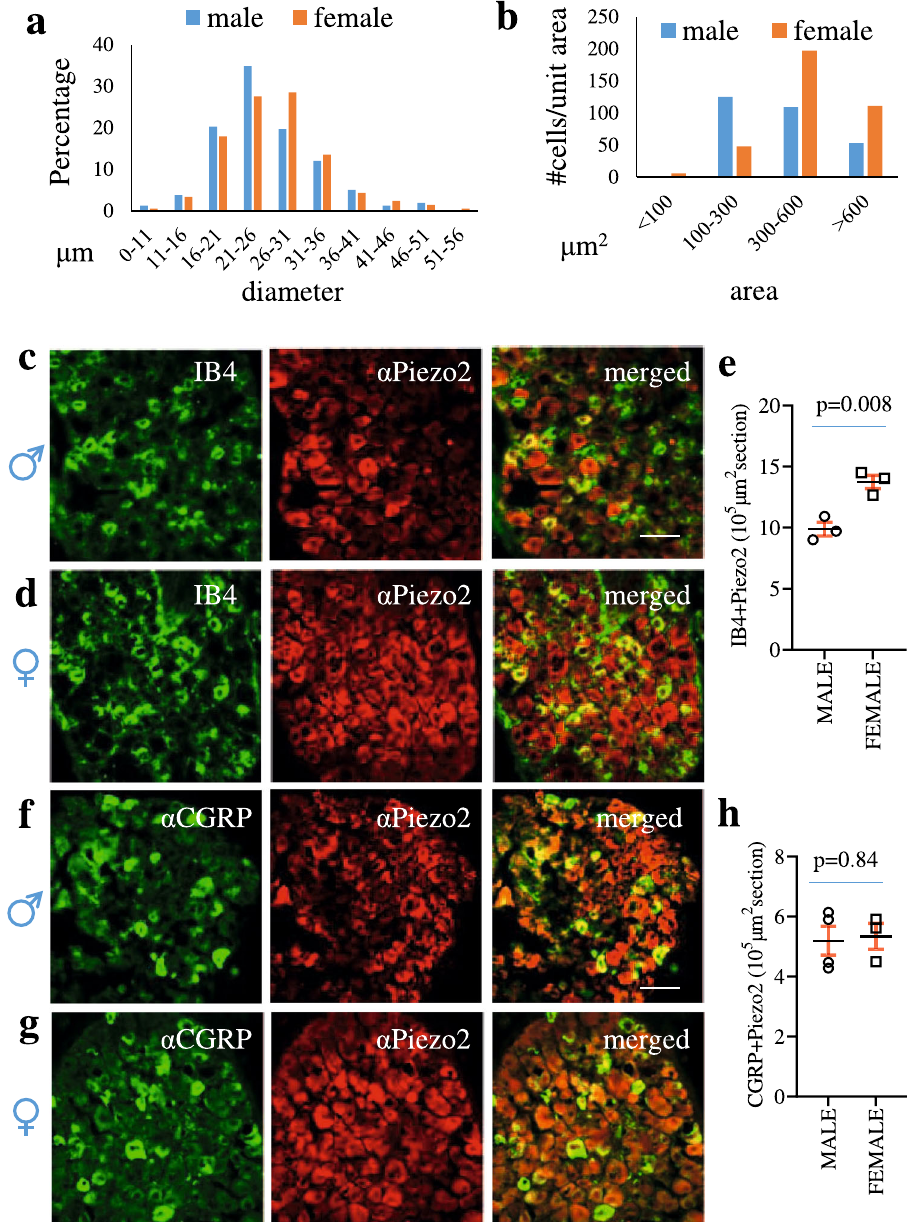
Fig. 3 | SexdifferentialexpressionofPiezo2in subtypes ofDRG neurons.a The percentage of Piezo2-expressing dorsal root ganglia (DRG) neurons distributes to each category de fi ned by diameters of cell-sizes. Data are from DRG of 3 biologi- cally independent male mice (162 neurons) and DRG of 3 biologically independent female mice (208 neurons). b The numbers of Piezo2-expressing DRG neurons are categorized into different groups according to the size of the neurons by area ( µ m 2 ). Data are from male (318 neurons measured) and female (503 neurons mea- sured) mice. c , d Double immunostaining of Isolectin-IB4 and Piezo2 in male and female mice. e Summarized data shows IB4 and Piezo2 co-expression in 10 5 µ m 2